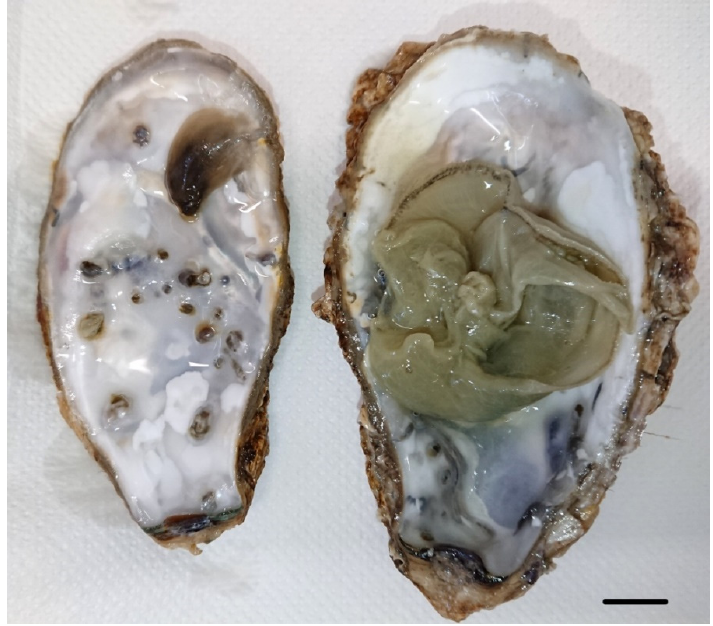
Figure 3. Lower (left) and upper (right) valve of the oyster Magallana gigas infested by Rocellaria dubia . Scale bar—10 mm.